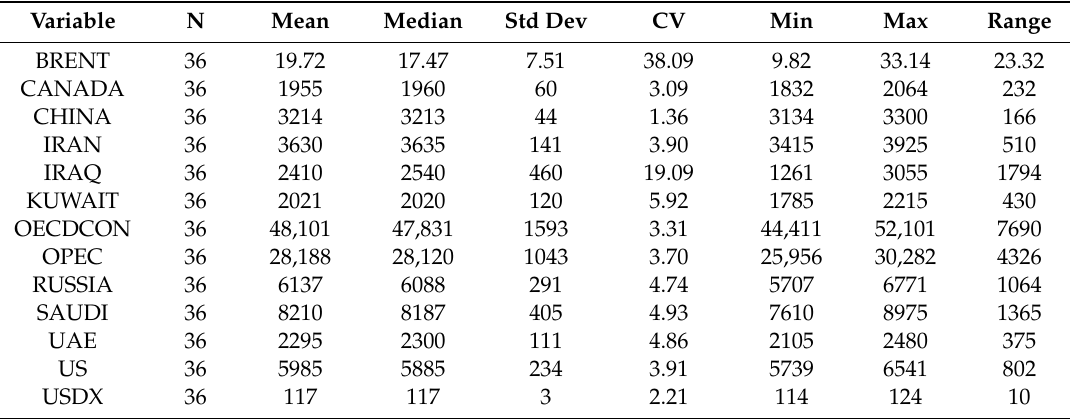
Table 5. Panel 1 period (1998–2000): summary statistics.